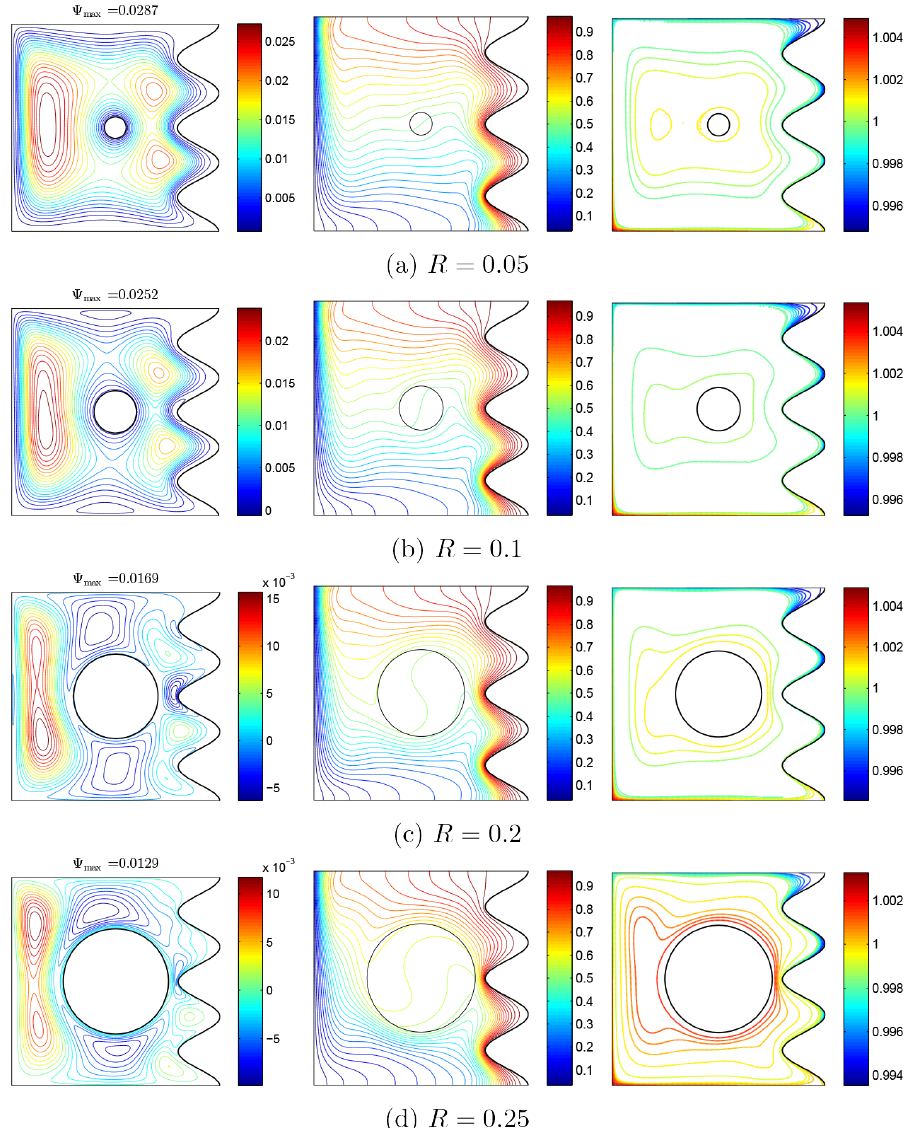
Figure 16. Variations of the ( left ) streamlines, ( middle ) isotherms, and ( right ) nanoparticle distribution evolution by the radius of the rotating cylinder ( R ) for Case 1 ( Ω ), Ri = 10, φ = 0.02 and N = 3. Considering the density of isothermal lines, the maximum amount of local Nu is seen at the first concave region of all amounts of R . At the second concave region, considering the proximity of rotating rigid body, the value of local Nu is maximum for large values of R , especially for R = 0.25. At the last concave region, density of isothermal lines becomes very low and Nu is expected to be lower at the third peak, compared to the other two peaks. This is clearly observed in Figure 17a. At R = 0.25, as a result of density at the first two peaks and remarkable reduction of temperature gradient at the last concave region, the behavior of local Nu is highly noticeable. Considering the isothermal lines, Nu of rotating body may be described this way: nearly at the beginning of motion on the wall, temperature gradient is negative, while at the symmetrically opposite region is positive. Thus, a Sin behavior in the Nu of rotating wall, including a negative minimum and a positive maximum, is observed. Considering the aggregation of temperature gradient at R = 0.25 and the presence of vortexes, local Nu has a remarkable growth at its positive maximum, in comparison with other values of R (Figure